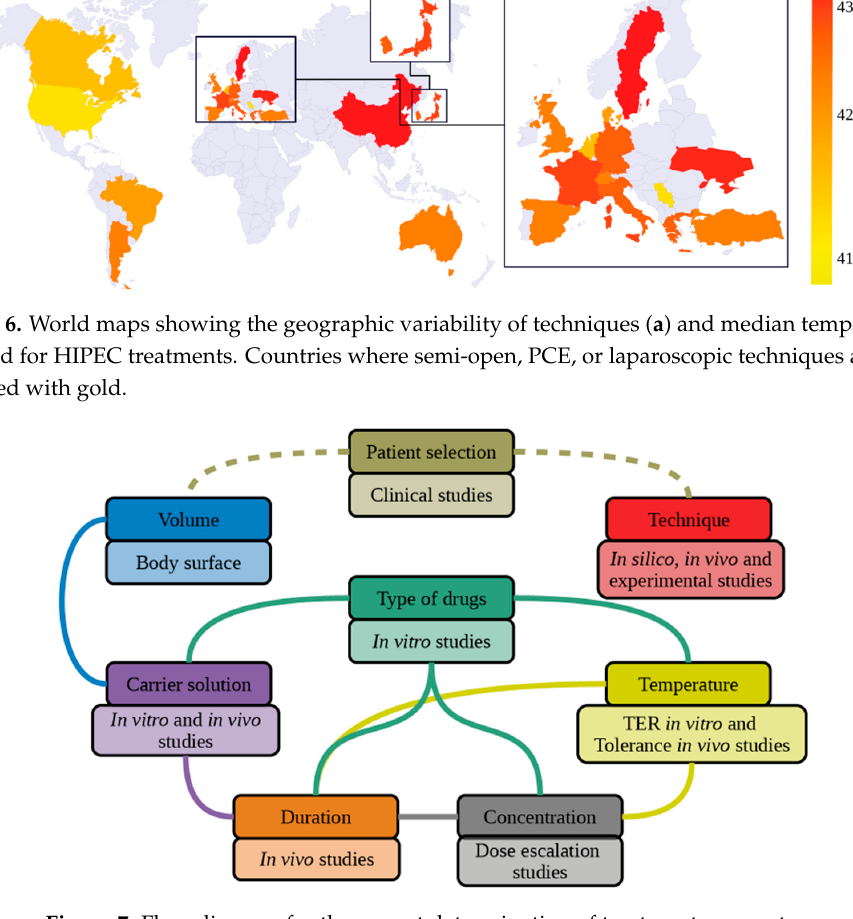
Figure 7. Flow diagram for the correct determination of treatment parameters.